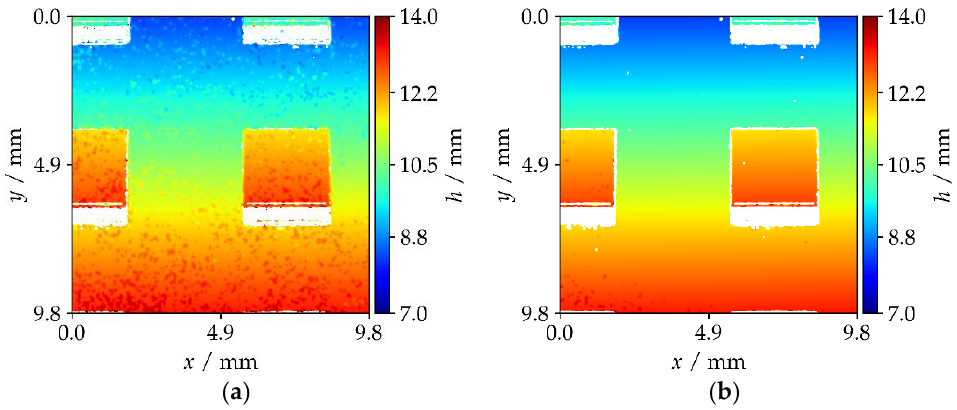
Figure 13. Height map ℎ of the combined steps sample data using ( a ) maximum filter: combination errors due to discrete hence imprecise shape-from-focus data; ( b ) the Gaussian filter: almost no combination errors occur onto the Gaussian fit output.